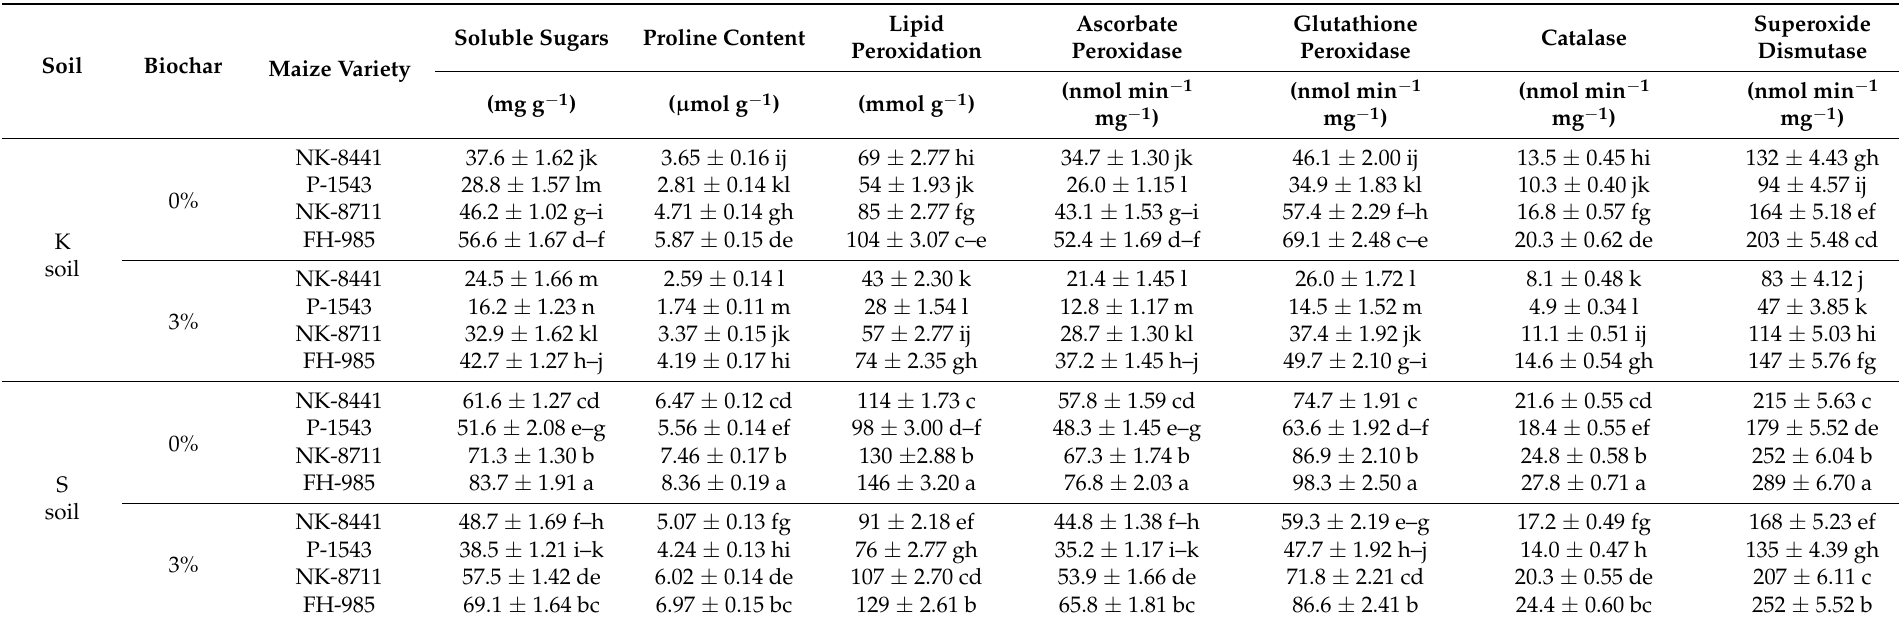
Table 5. Plant stress-related metabolites and antioxidant activities of studied maize cultivars NK-8441, P-1543, NK-8711, and FH-985 with the application of biochar in tannery polluted Kasur and Sialkot